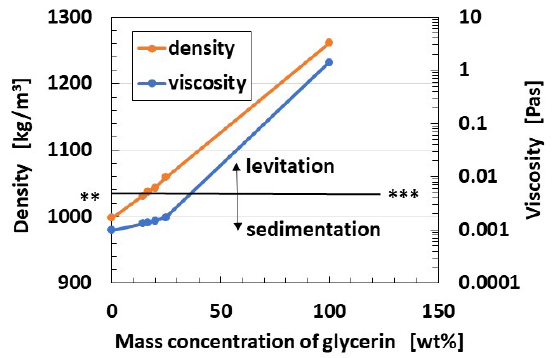
Figure 5. Density and viscosity of the liquid used in the equilibrium sensor mimicking a saccule.